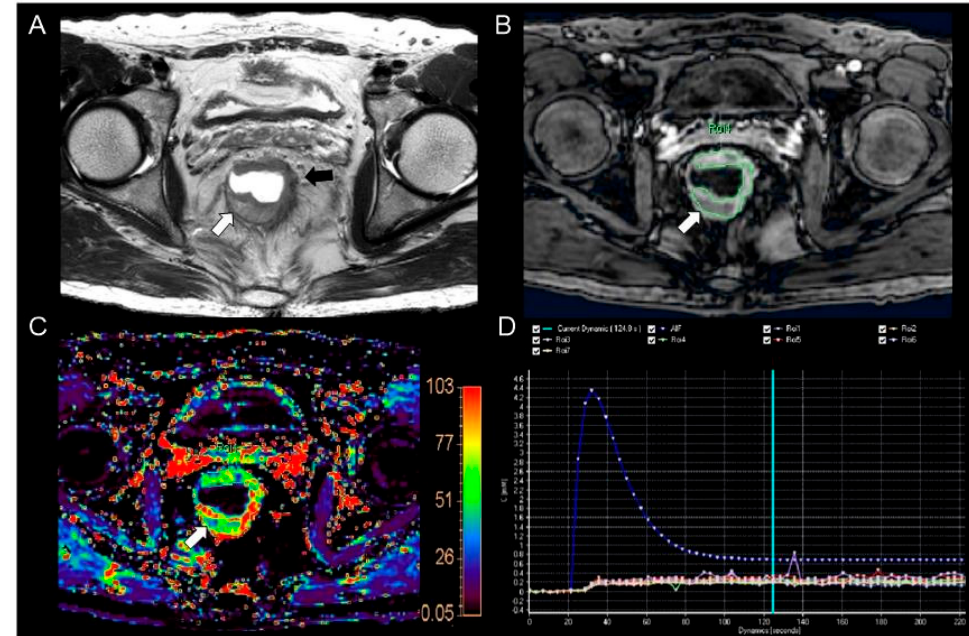
Figure 3. MR images from a 54 − year − old man with pathologically proven moderately differentiated rectal adenocarcinoma. ( A ) The T2 − weighted axial image shows eccentric wall thickening (black arrow) in the lower rectum. Focal high signal intensity is seen (white arrow) in the posterior portion of the tumor. The focal lesion was histologically revealed to be mucin accumulation in the tumor. ( B ) The post − contrast axial 3 − dimensional spoiled gradient echo image shows a heterogeneous enhancement in the corresponding tumor. Relatively poor enhancement is seen in the mucin accumulation site (arrow). ( C ) The color-coded K trans map shows a wide range of colors from purple to red in the corresponding tumor. Mixed blue and purple colors are seen in the mucin accumulated portion (arrow). The calculated mean K trans was 0.063 min − 1 . ( D ) The concentration time curve shows a plot of arterial input function (AIF, blue line), which was implemented automatically with the population − based data and seven plots from the consecutive seven regions of interest (ROIs − 1 to 7) in the whole tumor (different colored lines).